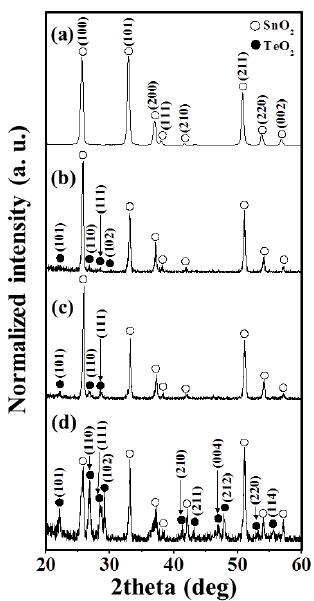
Figure 2. XRD images of ( a ) SnO 2 nanowires, TeO 2 branched SnO 2 nanowires with annealed at